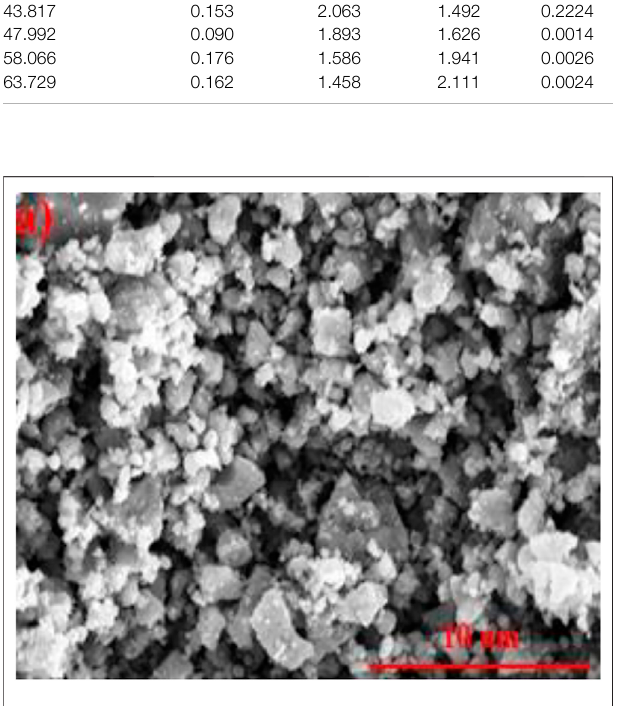
FIGURE 3 | SEM image of the synthesized LMO